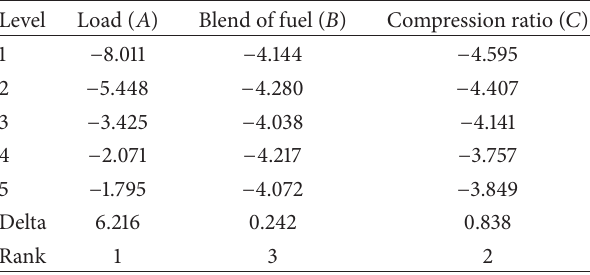
Table 6: Response for the signal-to-noise